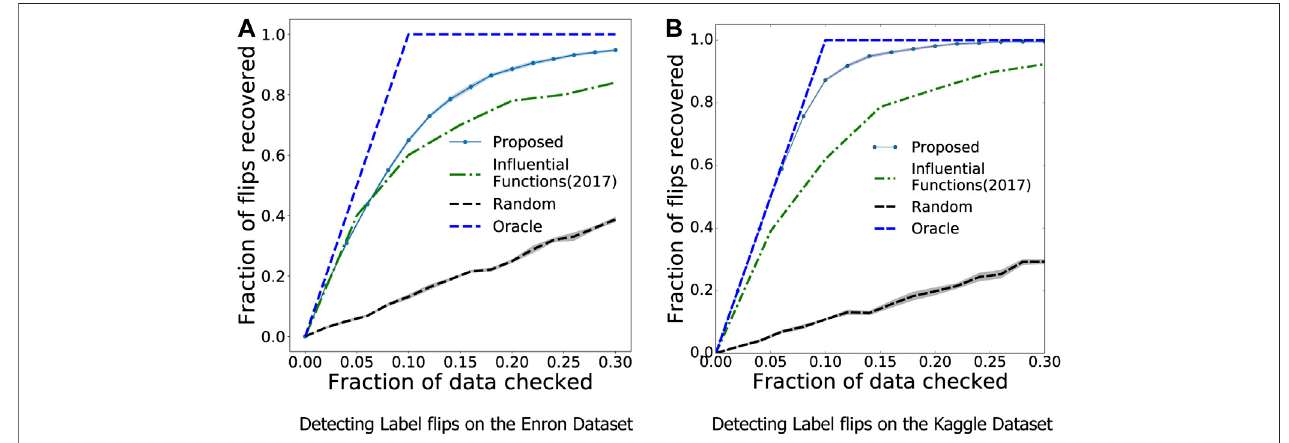
FIGURE5| MARGINcanbeusedto fi ndsampleswithincorrectlabelsef fi ciently,muchbetterthancompetingin fl uencesamplingbasedapproaches.The “ Oracle ” here is the best case scenario, where the samples checked are exactly the ones that are